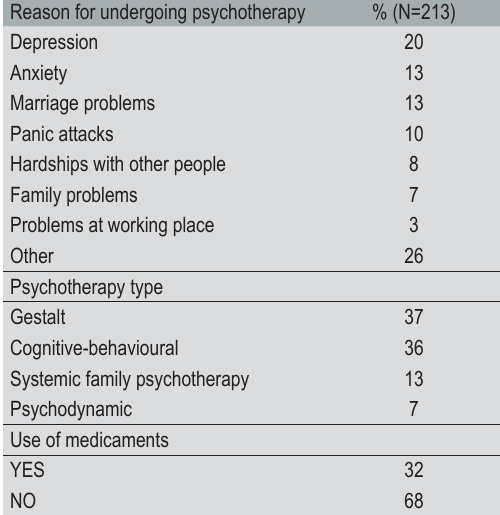
TABLE 2. Clinical traits of patients involved in psychotherapy in Bosnia and